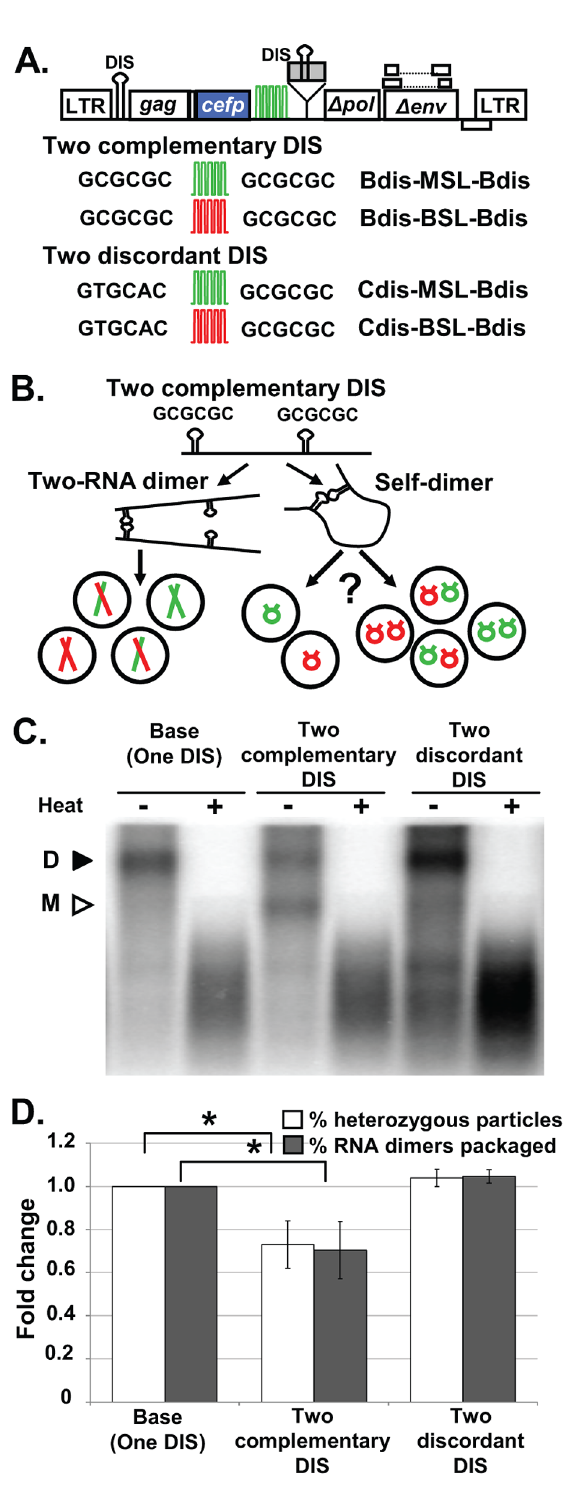
Figure 4. Encapsidation of HIV-1 RNAs containing two packaging/dimerization signals. (A) General structures of HIV-1 constructs containing two packaging signals. DIS sequences are shown; the gray box denotes the additional packaging signal inserted in pol . Other abbreviations are the same as in Figure 1. (B) Schematic representation of intermolecular and intramolecular dimers generated by RNAs containing two dimerization signals. (C) Representative nondenaturing Northern analyses of virion RNAs. Black and white arrowheads indicate the positions of RNA dimers and